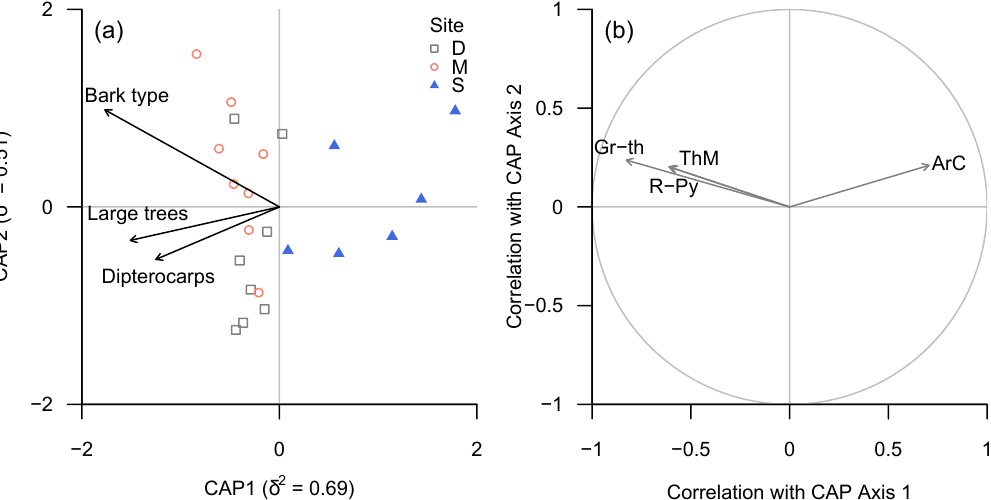
Figure 5. ( a ) CAP ordination plot of lichen community structure (taxonomic groups) according to continuous environmental (tree trait) variables, based on ‘plot-level’ data summarised for each plot. ( b ) Spearman rank correlation coefficients between CAP axes and individual taxa for which | ρ | ≥ 0.6. Taxonomic groups in ( b ): ArC— Cryptothecia , Gr-th—thelotremoid Graphidaceae, R-Py— Phyllopsora and Krogia , ThM— Melanophloea ).